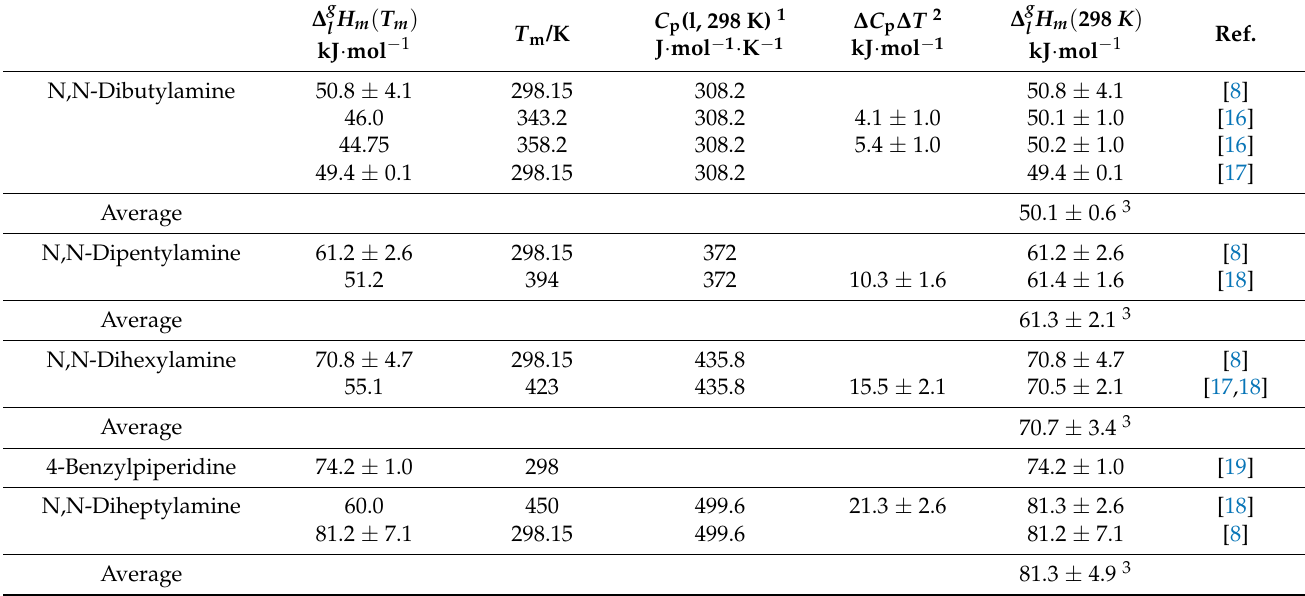
Table 2. Temperature adjustments of literature vaporization